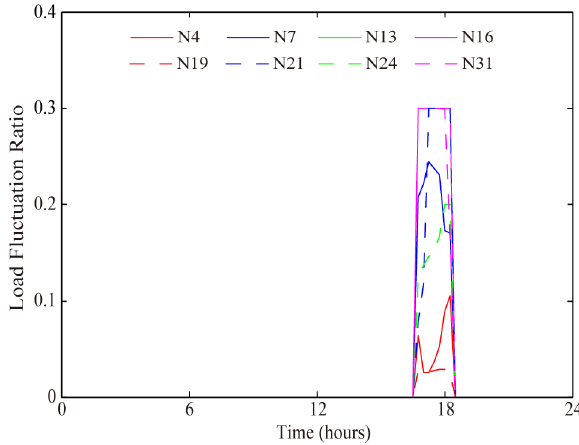
Figure 10. Load fluctuation ratio.